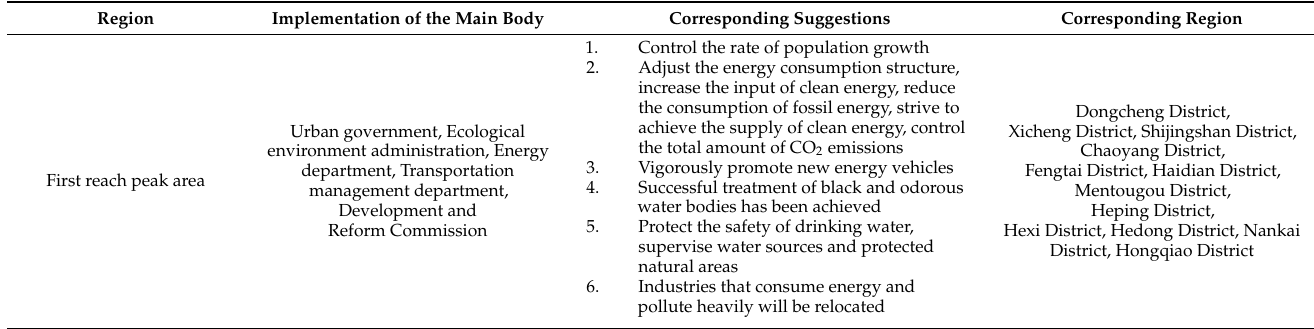
Table 3. Suggestions for areas that are the first to achieve carbon peak.